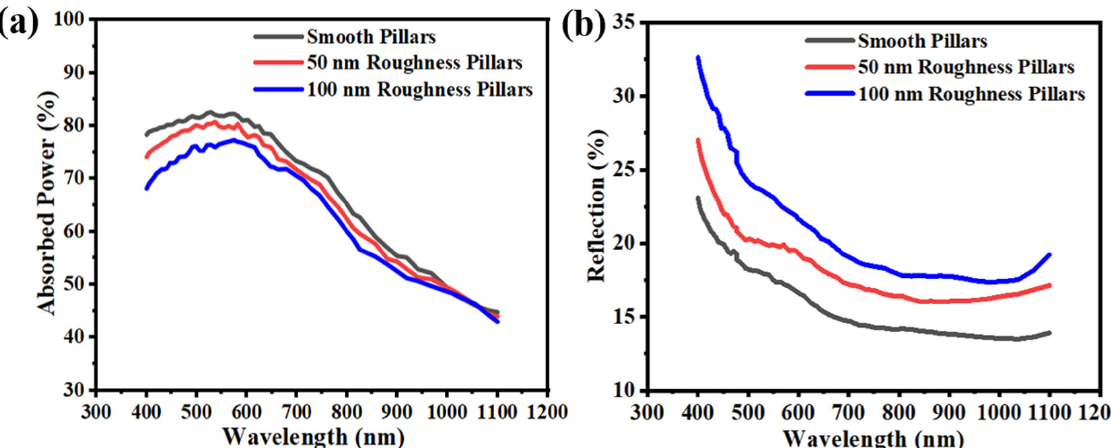
Figure 6. ( a ) The absorption spectrums and ( b ) the reflection spectrums of micropillar arrays with different roughness at wavelengths of 400–1100 nm.